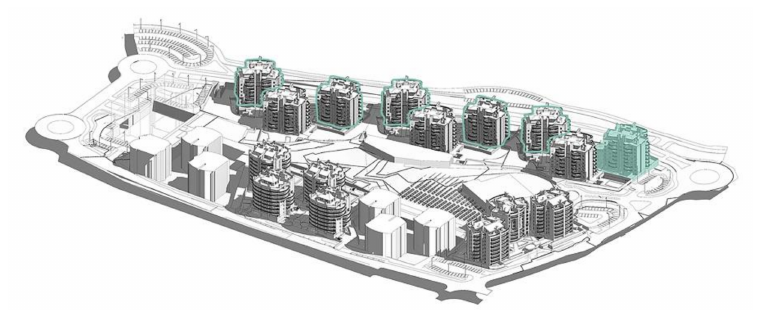
Figure 8. Selected building for the performed energy analysis.